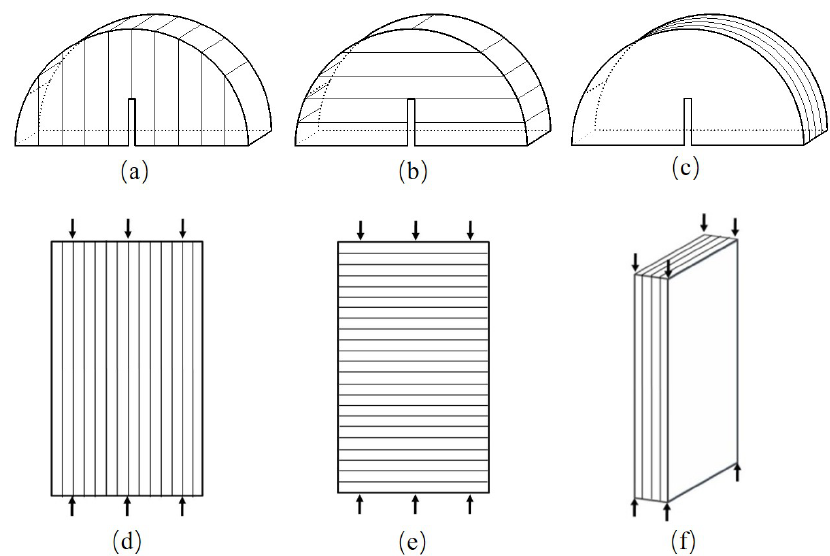
Figure 5. Three modes of shale fracture specimens and corresponding non-cracked specimens: ( a ) splitter-mode fracture specimen, ( b ) arrester-mode fracture specimen, ( c ) divider-mode fracture specimen, ( d ) splitter-mode non-cracked specimen, ( e ) arrester-mode non-cracked specimen, ( f ) divider-mode non-cracked specimen.